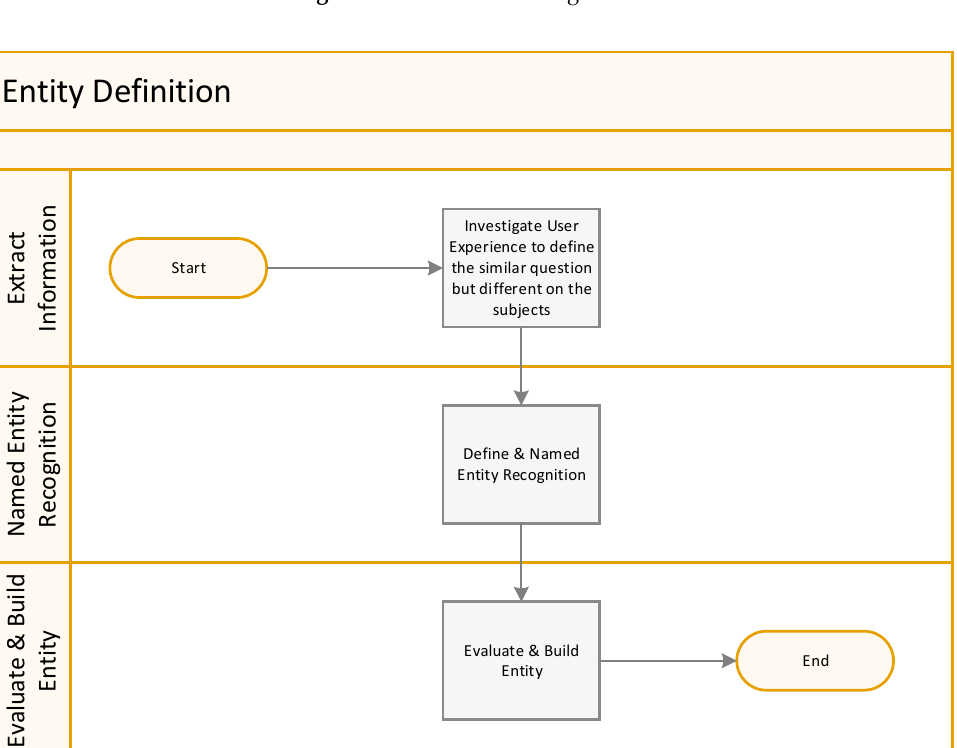
Figure 7. Process of defining Entity.